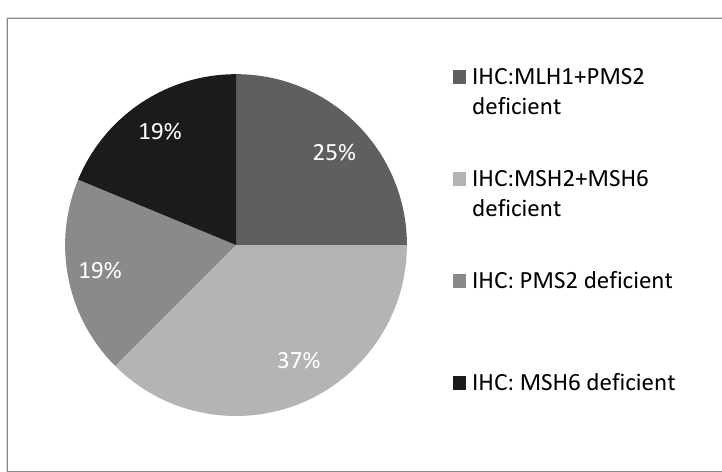
Figure 2. Breakdown of all screen-positive individuals by MMR protein deficiency. Note: MLH1 + PMS2 categories refer to patients with absent MLH1 + PMS2 expression on IHC and absent MLH1 promoter methylation.